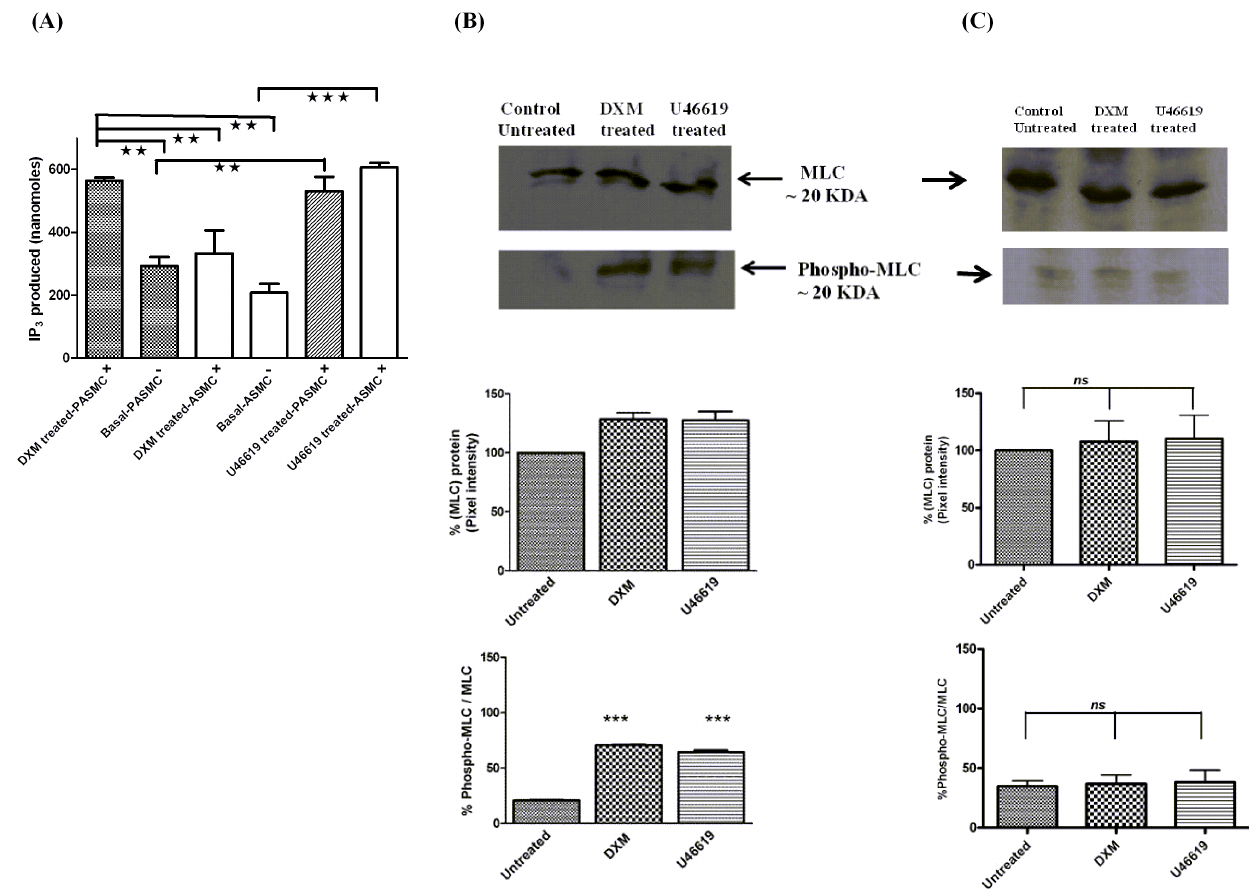
Figure 6. IP 3 measurement in porcine PASMCs and ASMCs, and analysis of MLC and phospho MLC in porcine PASMCs. A . Bar plot representation of total IP 3 produced (nanomoles) in pPASMCs and pASMCs upon treatment with DXM. pASMCs and pPASMCs were stimulated with DXM (500 m M) or U46619 (1 m M) which was used as a positive control. Shown are the agonist-independent or basal activity (-), and activity after stimulation ( + ) with agonist. Results are from a minimum of 4 independent experiments performed in triplicate. A one way ANOVA with Tukeys post hoc test was used to check the significance. The double asterisk indicate a significant difference in the amount of IP 3 produced after stimulation with 500 m M DXM in pPASMCs with respect to DXM response in pASMCs at significance level of **p , 0.01. Error bars represent mean 6 SEM. B . Representative Western blot image and the respective densitometry analysis of three blots showing total MLC and phospho MLC in pPASMCs after DXM-treatment (500 m M). PASMCs treated with buffer alone or U46619 (1 m M) treated cells were used as controls. Both DXM and U46619 stimulated MLC phosphorylation. Significant results were obtained between untreated vs. DXM treated and untreated vs. U46619 treated at significance level ***p , 0.001 for phospho-MLC. C . Representative Western blot image and the respective densitometry analysis of three blots showing total MLC and phospho MLC in pASMCs after DXM-treatment (500 m M). No significant change in total MLC expression or phospho MLC was found between untreated sample and U46619 treated or DXM treated sample. The results are from a minimum of three independent experiments (n=3) and shown as mean + SEM.